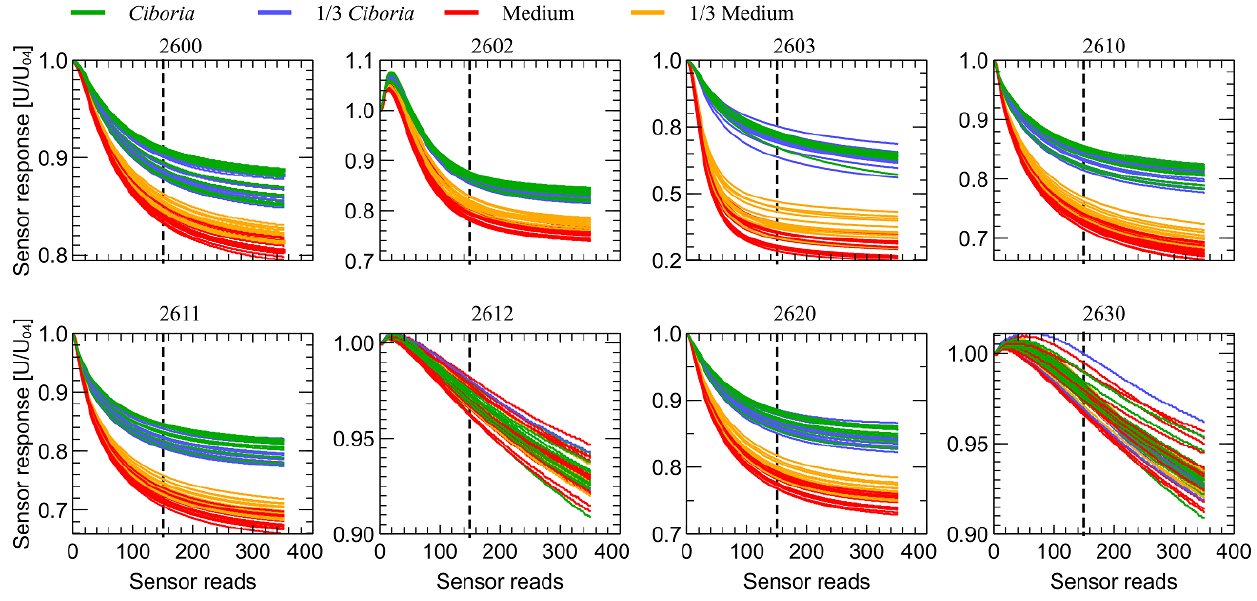
Figure A2. Sensors’ transient response in the fourth stage of the observation time (after the closing of the sensor chamber shutter), versus time elapsed from the moment of voltage reduction. The sensor’s response voltage is expressed as normalized by the voltage at the beginning of the stage of observation time U 04 . Variants of the measured samples are marked by color lines. The sensor type is indicated above the subfigures. The vertical dotted line indicates the observation moment at which data presented in Figure A4 are